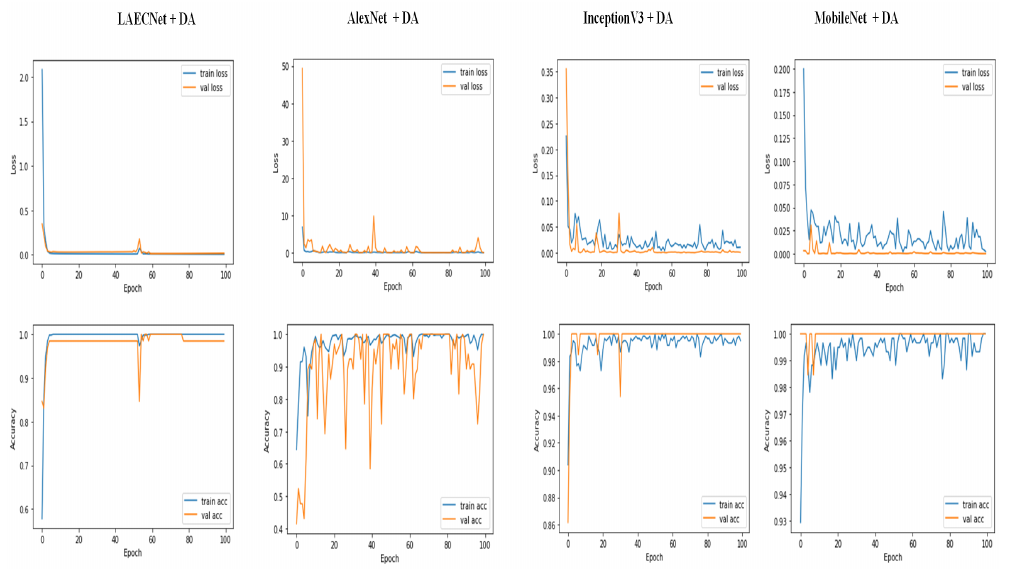
Figure 9. Losses ( upper ) and accuracy ( lower ) during training and validation using DA